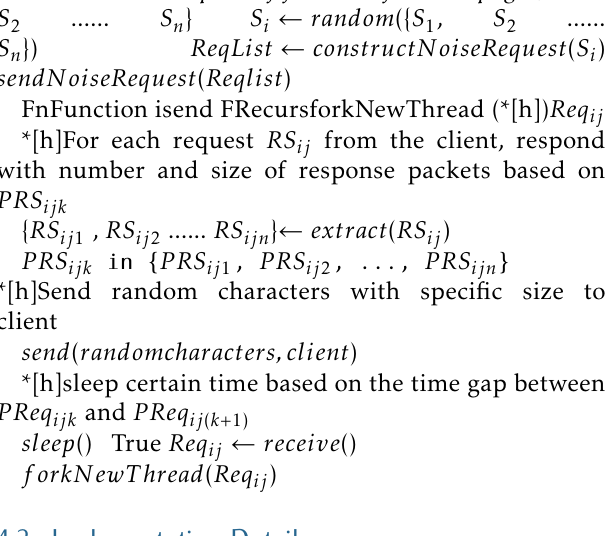
Figure 2. Sample of recorded network traffic. The format is